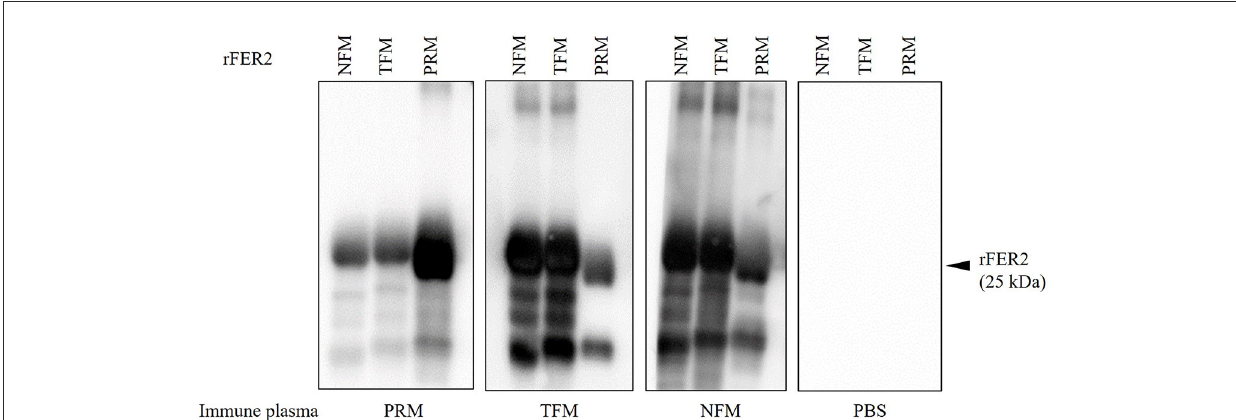
FIGURE4 The production of specific antibodies in the plasma from chickens immunized with recombinant ferritin 2 (rFER2) proteins. Four chickens per group were immunized with rFER2, separately. The plasmas were isolated from each immunized chicken, and the production of antibodies specific to rFER2 in the plasma were detected by Western blotting. The cross-reactivities of immune plasmas with each rFER2 were tested by Western blotting. The arrowhead indicates the predicted molecular weight of rFER2 ( ∼ 25 kDa).